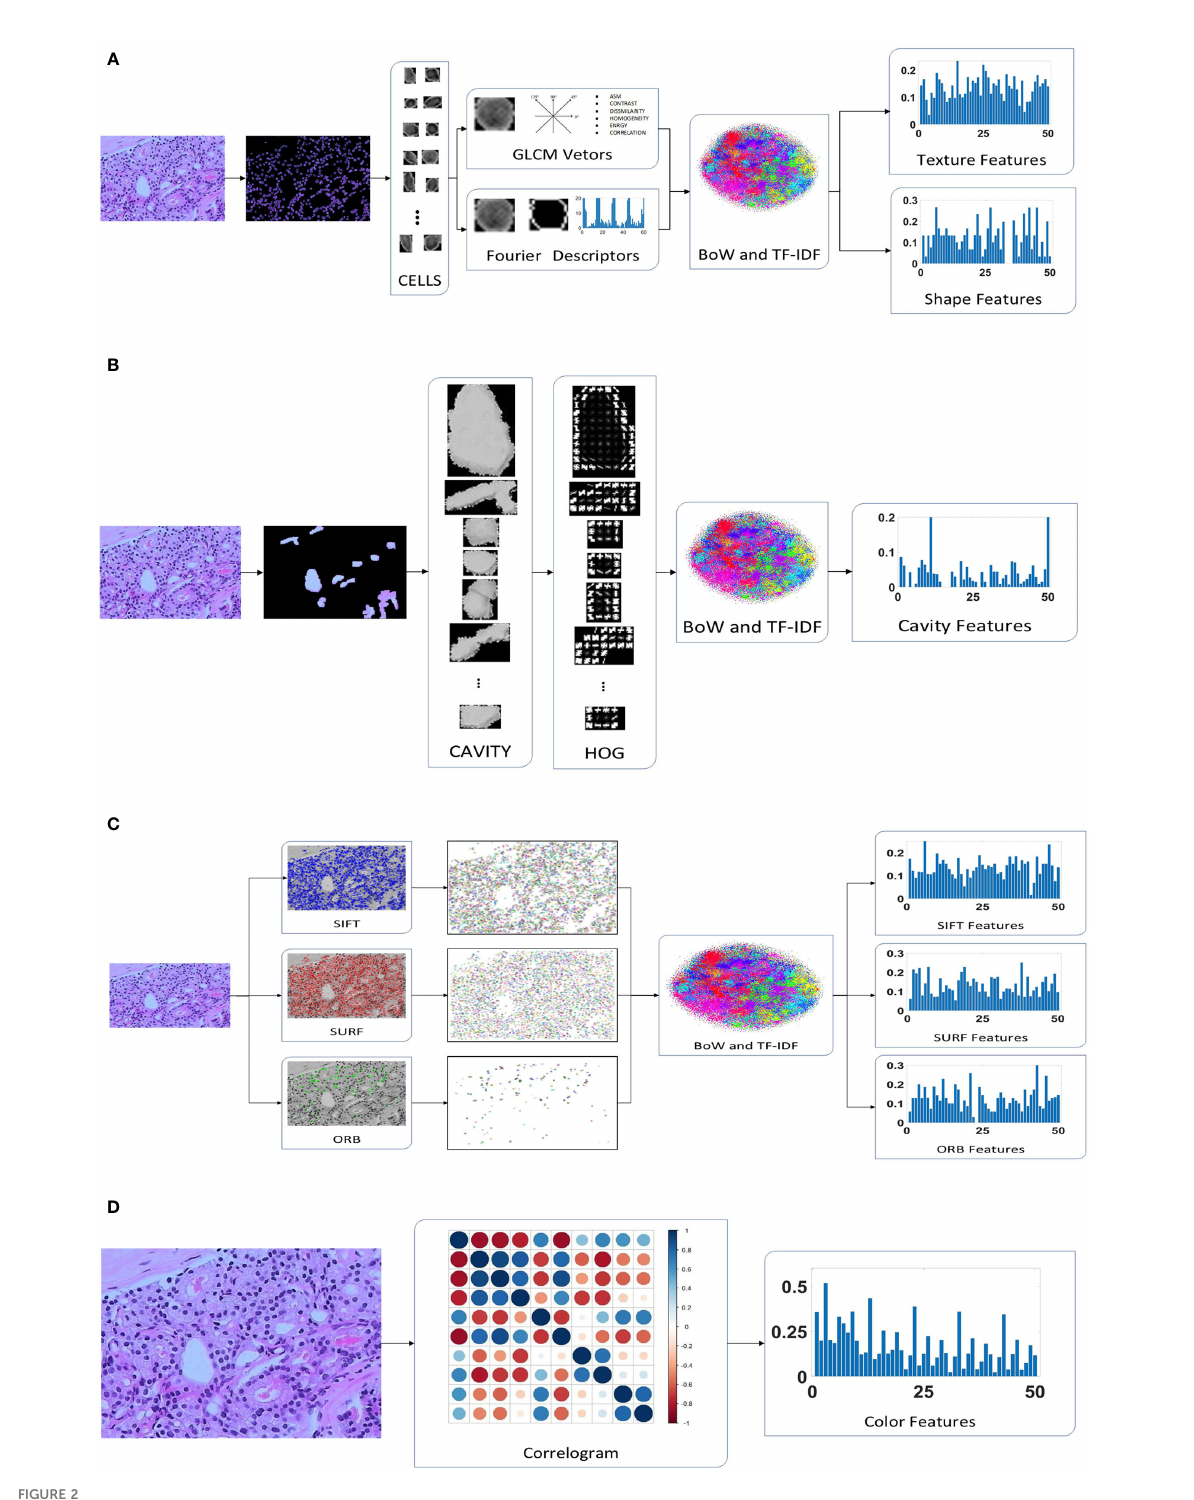
FIGURE 2 Hand-crafted feature extraction: (A) texture and shape feature extraction of the cell nuclei; (B) cavity feature extraction; (C) feature extraction; (D) color feature